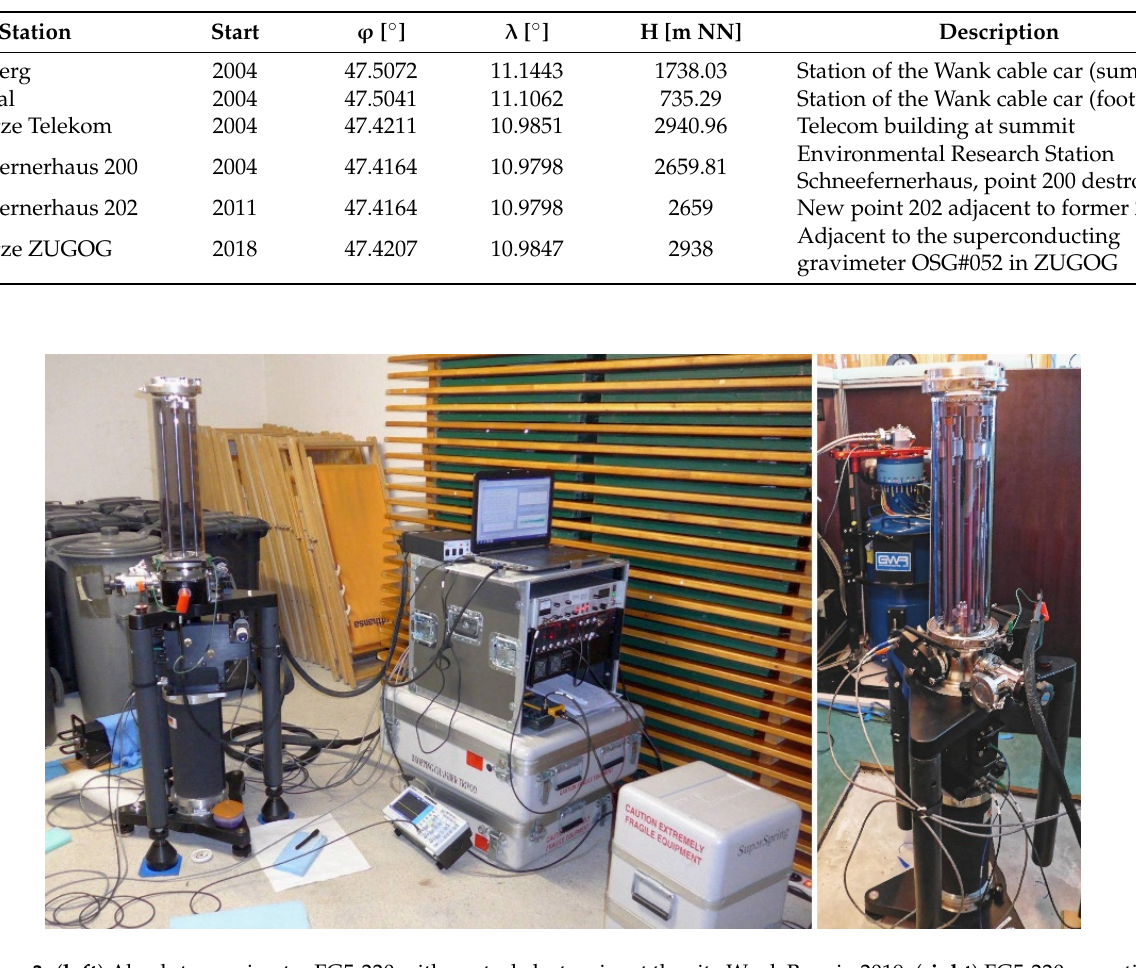
Figure 3. (left) Absolute gravimeter FG5-220 with control electronics at the site Wank Berg in 2019; (right) FG5-220 operating close to the superconducting gravimeter OSG#052 at Zugspitze.